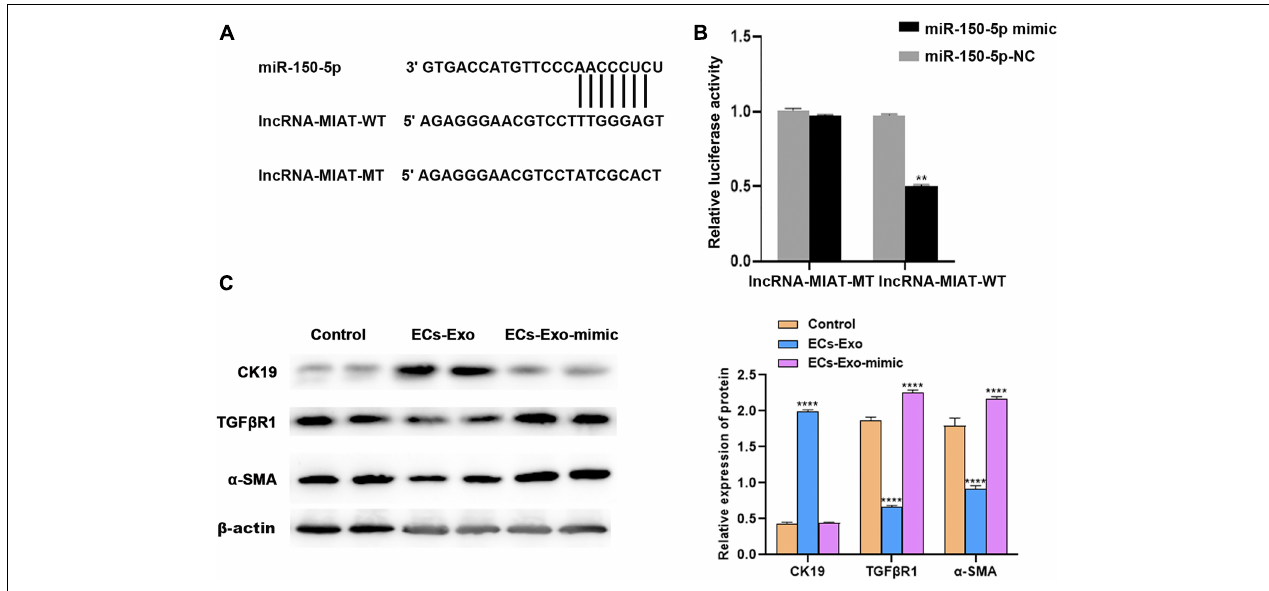
FIGURE 3 | LncRNA-MIAT in ADSC-Exos alleviates endometrial fibrosis by targeting miR-150. (A) Schematic representation of the miR-150 site in lncRNA-MIAT-3’UTR. (B) Luciferase activity was assayed in TGF- β 1-induced ESC injury co-transfected with miR-150 and luciferase reporters containing lncRNA-MIAT-3’UTR. (C) Western blot analysis of CK19, TGF β R1, and α -SMA protein expression in TGF- β 1-induced ESC injury co-cultured with or without ADSC-Exos in the absence or presence of miR-150 mimic. Data are presented as the mean ± SD ( n = 3). Two-tailed unpaired Student’s t -test, ** P < 0.01;